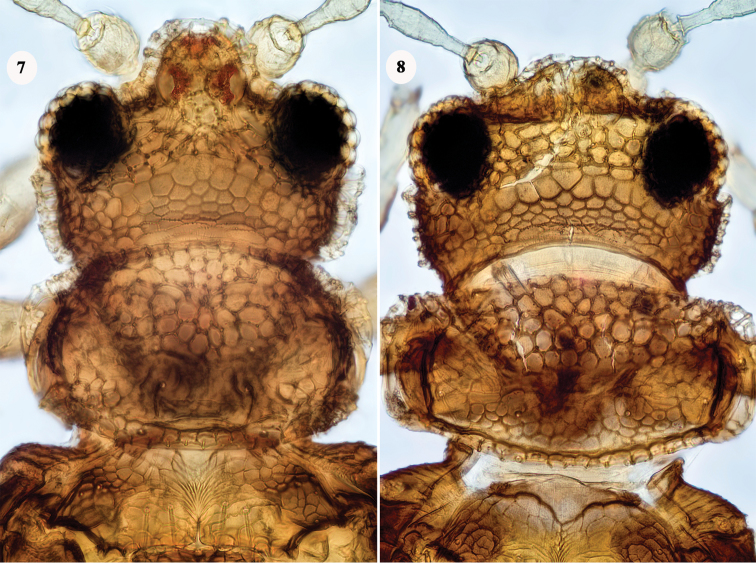
Astrothrips species, head and pronotum 7globiceps; female from Java, compared to holotype and identified by J.S. Bhatti 8parvilimbus; female from Madras on Erythrina, identified by T.N. Ananthakrishnan. [images by Manfred Ulitzka].